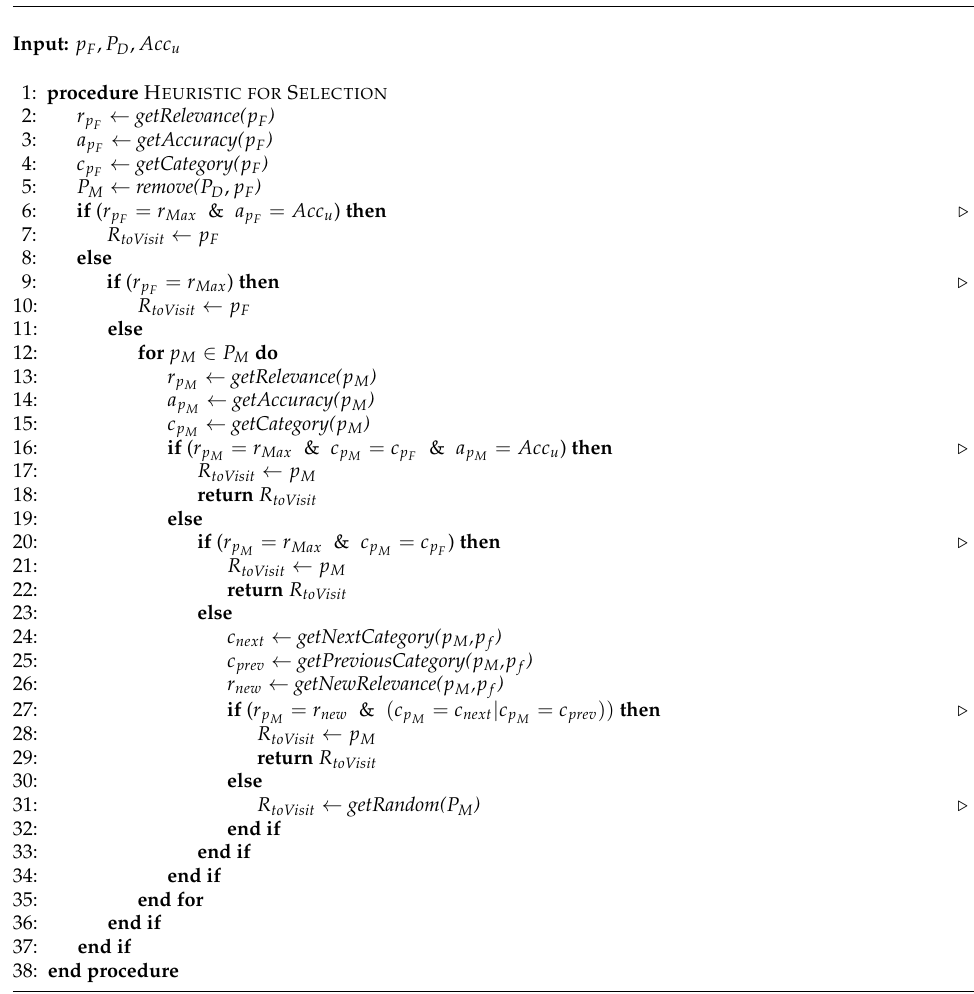
Algorithm 1 Artistic Period Selection